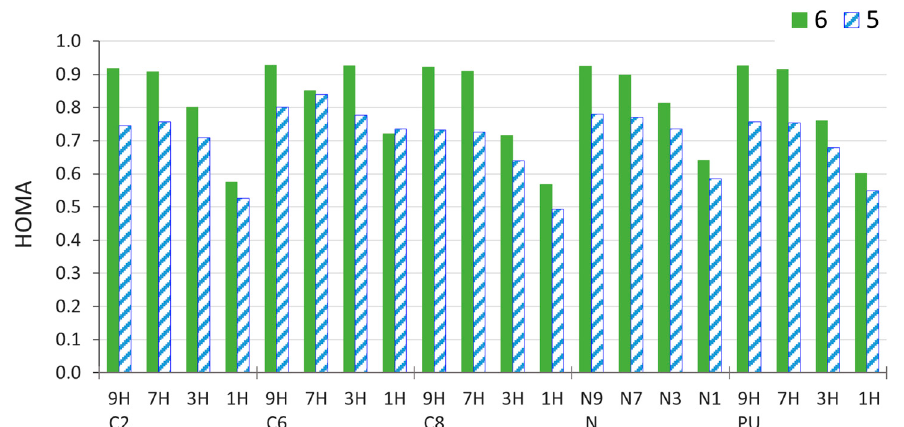
Figure 6. Values of HOMA index for 6- and 5-membered rings of C2-, C6-, C8-, and N-amino- substituted derivatives of purine in four tautomeric forms, calculated for the gas-phase geometry. PU is the values for unsubstituted purine.